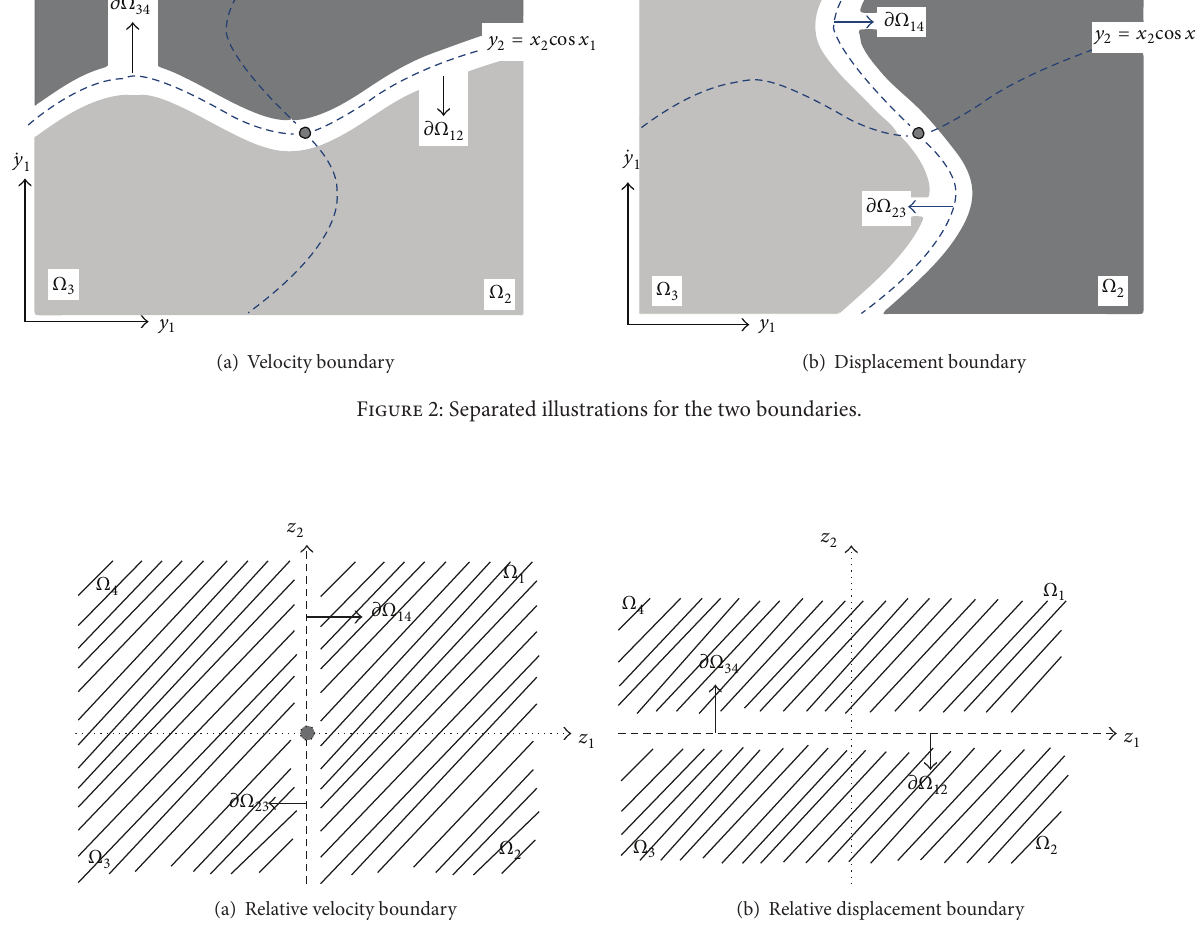
Figure 3: Separated illustrations for the two boundaries in the relative